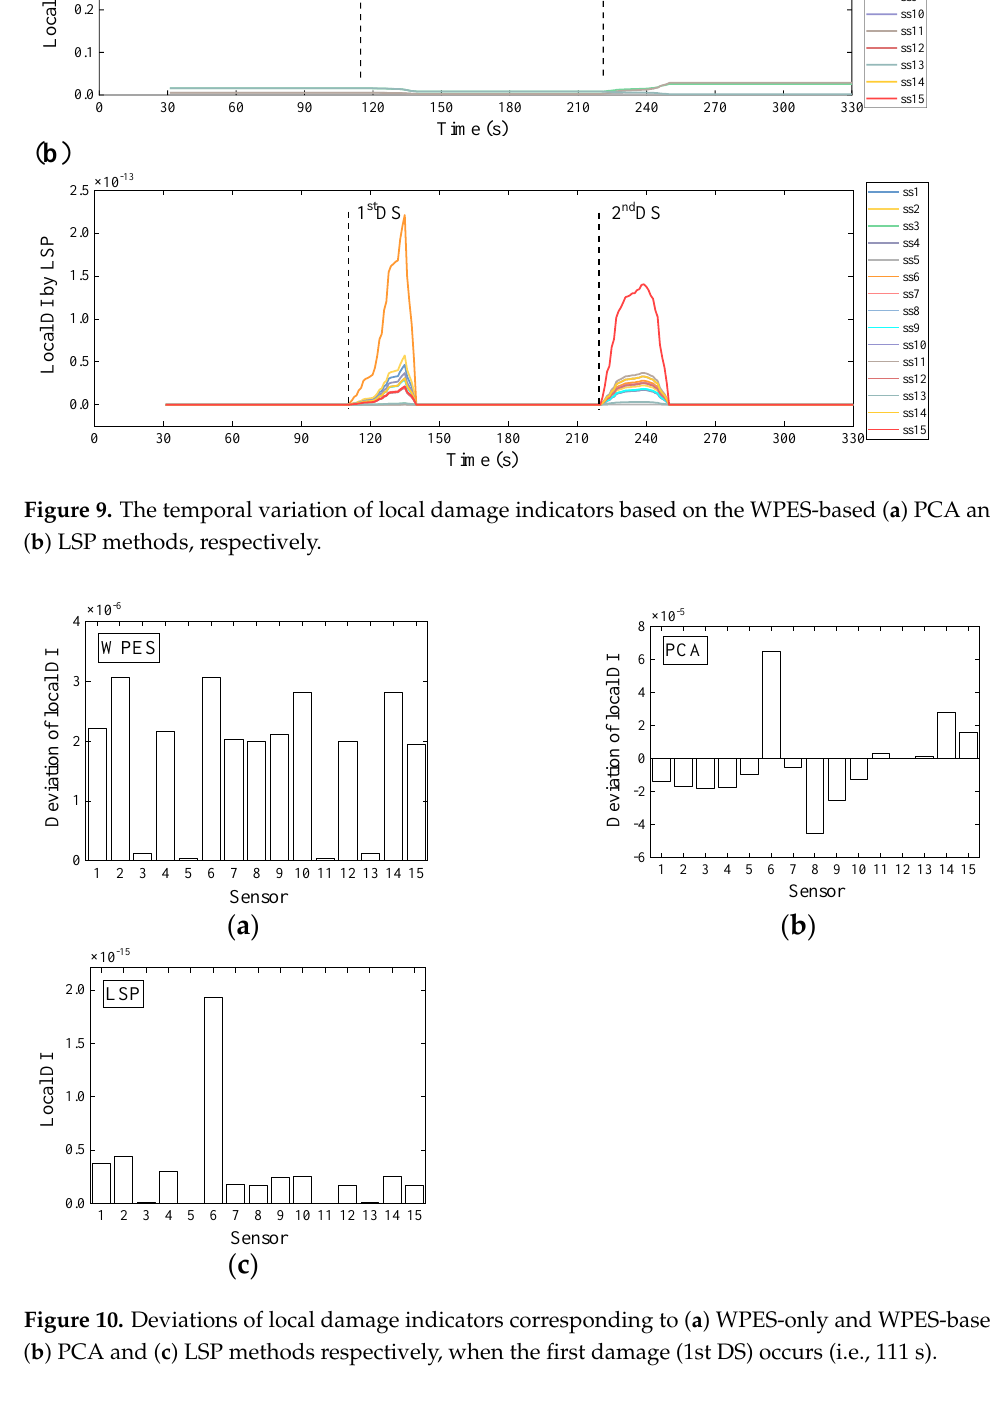
( d ) Figure 11. Deviations of local damage indicators corresponding to ( a ) WPES-only and WPES-based ( b , c ) PCA and ( d ) LSP methods respectively, when the second damage (2nd DS) occurs (i.e., 221 s). Note: WPES-based PCA method yields two results due to the different baselines used. It is evident from Figures 10a and 11a that the WPES values, i.e., wavelet-based strain response features, cannot locate damages because the effects of operating loads are not eliminated. For the DI values by PCA, the results of damage identification rely